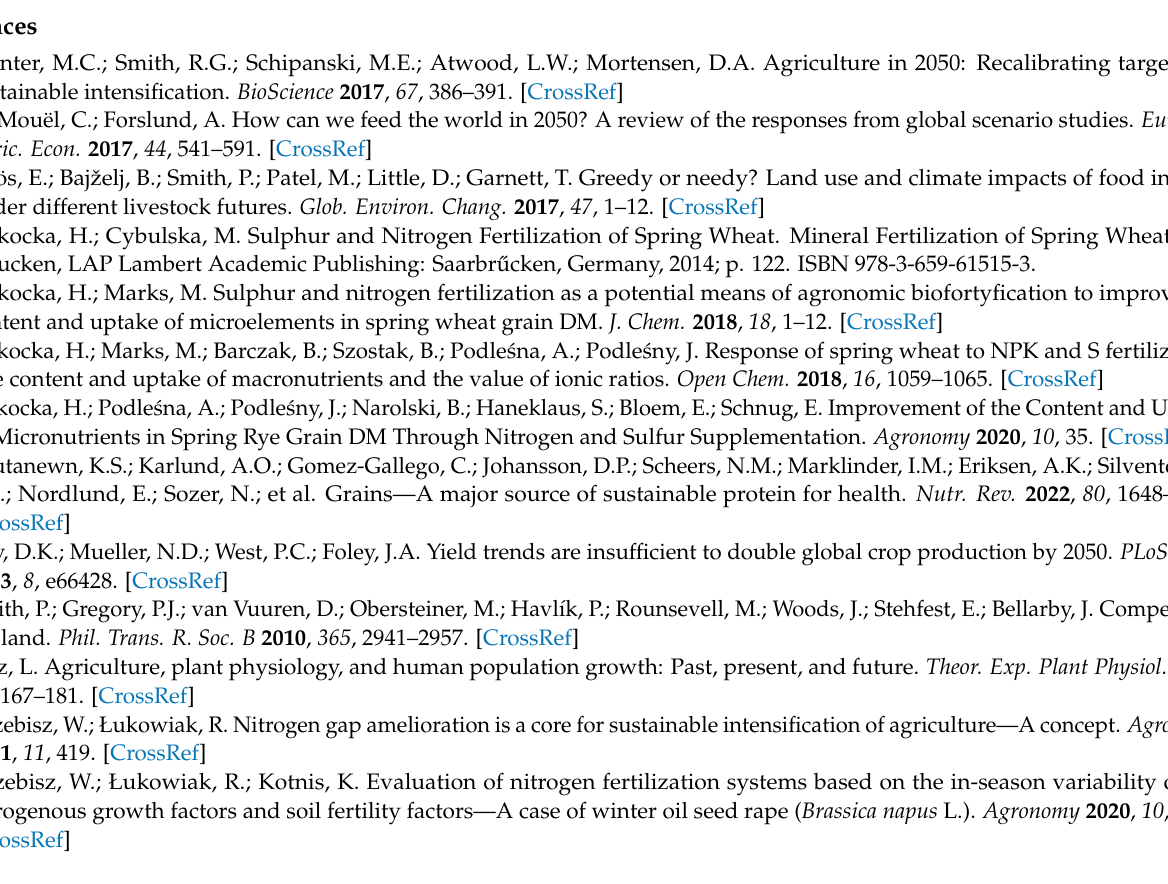
Figure A5. Effect of winter wheat protection with fungicides and rates of fertiliser nitrogen on unit productivity of direct costs. Similar letters in the column means a lack of significant differences using Tukey’s’ test . The vertical bar in the column refers to the standard error of the mean.